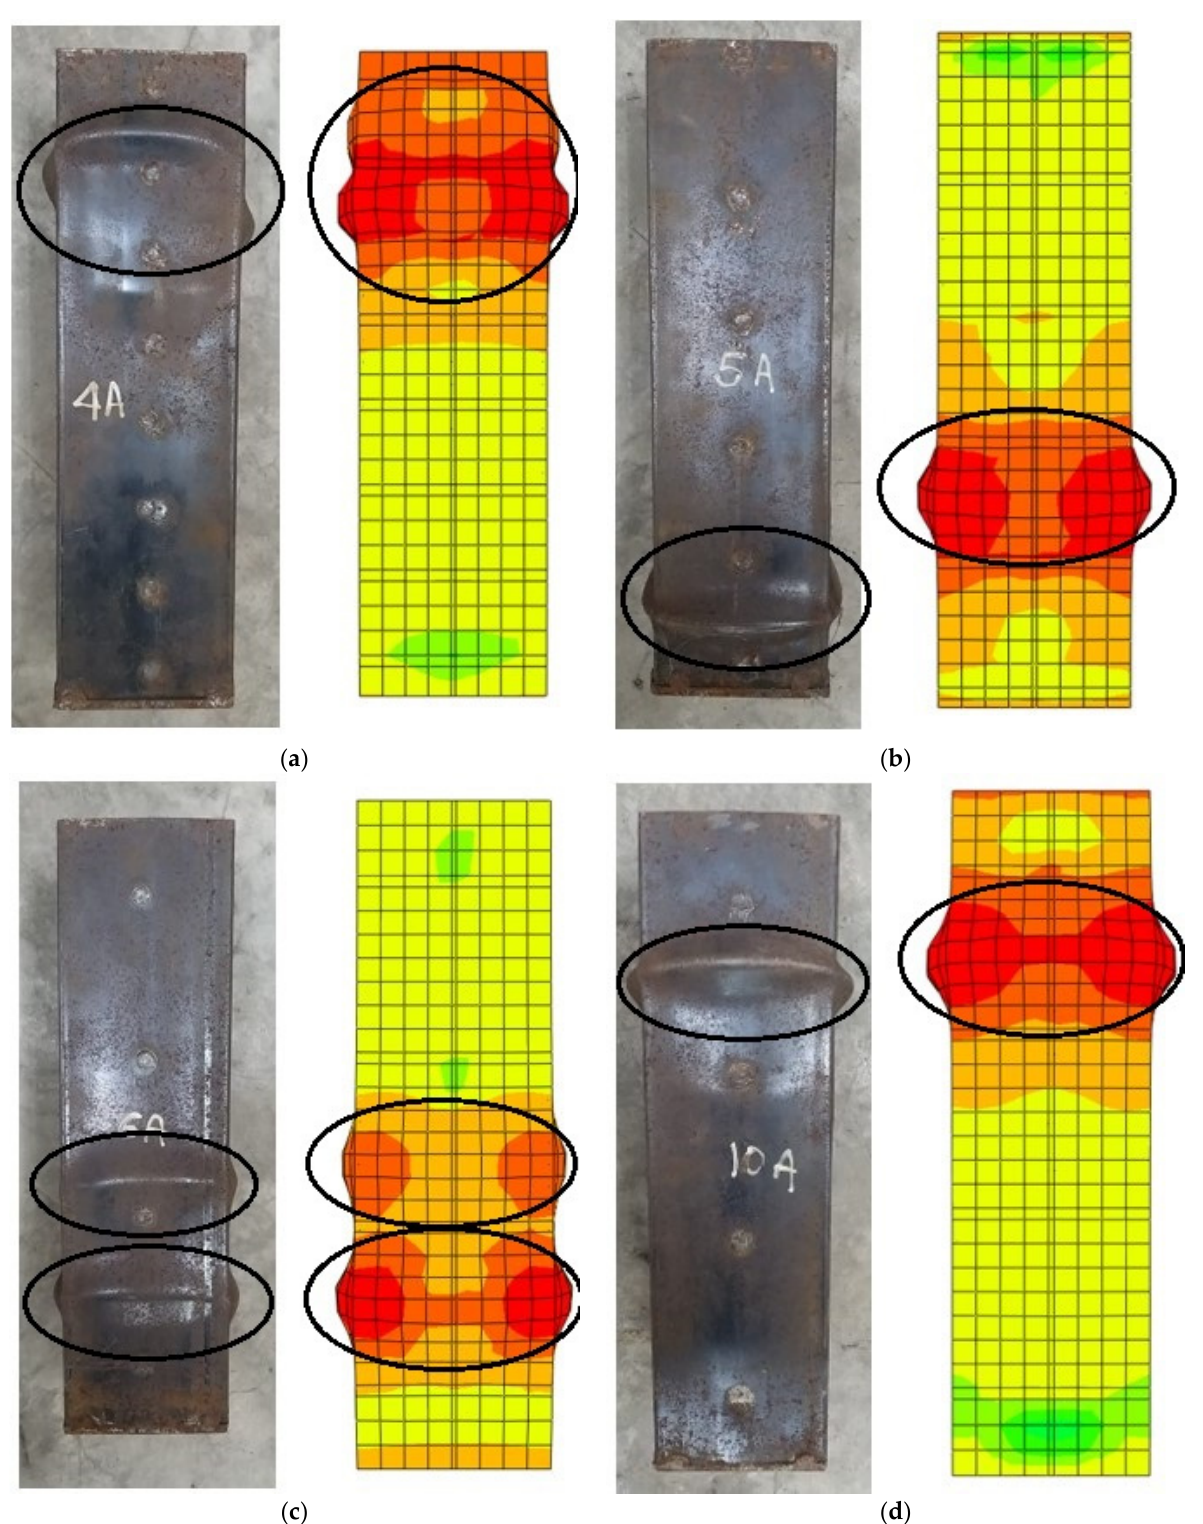
Figure 15. Comparison of the deformation shape of the square CFDST with plate